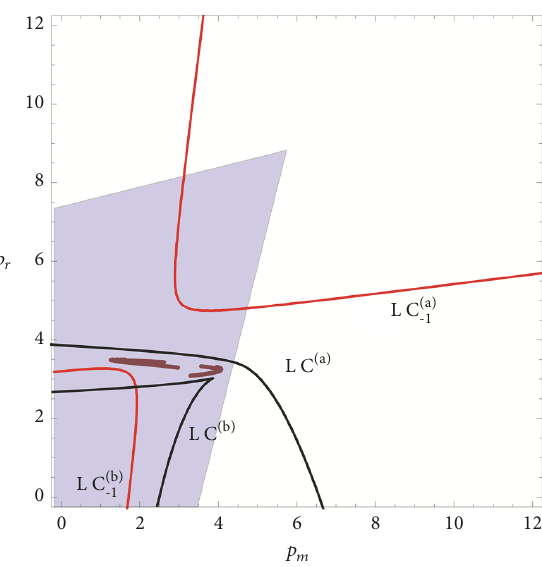
Figure 7: The basin of attraction when 𝛼 1 = 0.1,𝛼 2 = 0.1 .